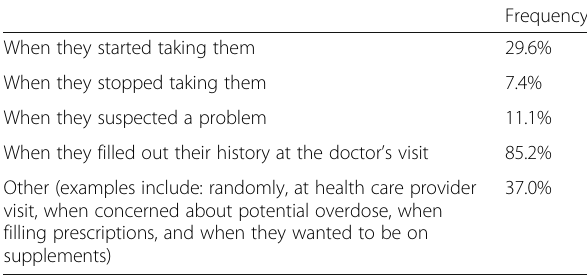
Table 4 When participants informed provider of CAM use ( N = 27)